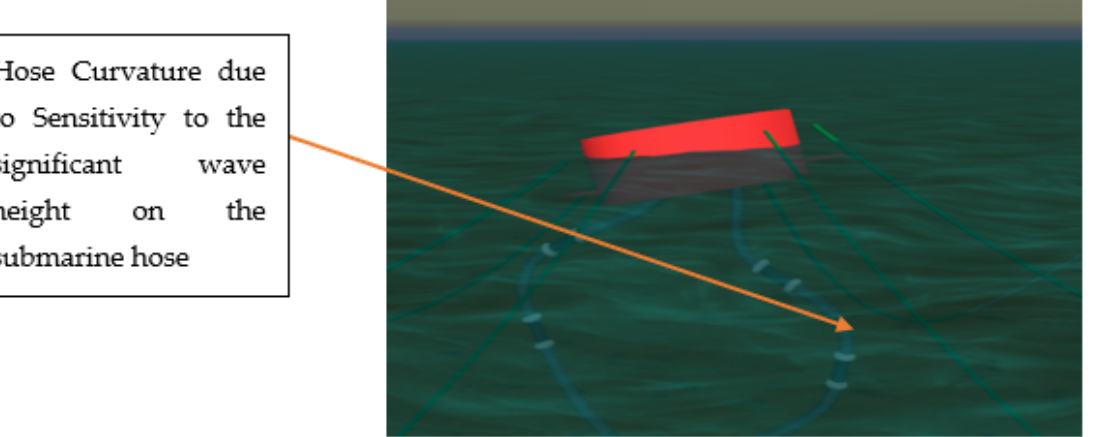
Figure 23. Curvature of submarine hose in Chinese-lantern configuration.